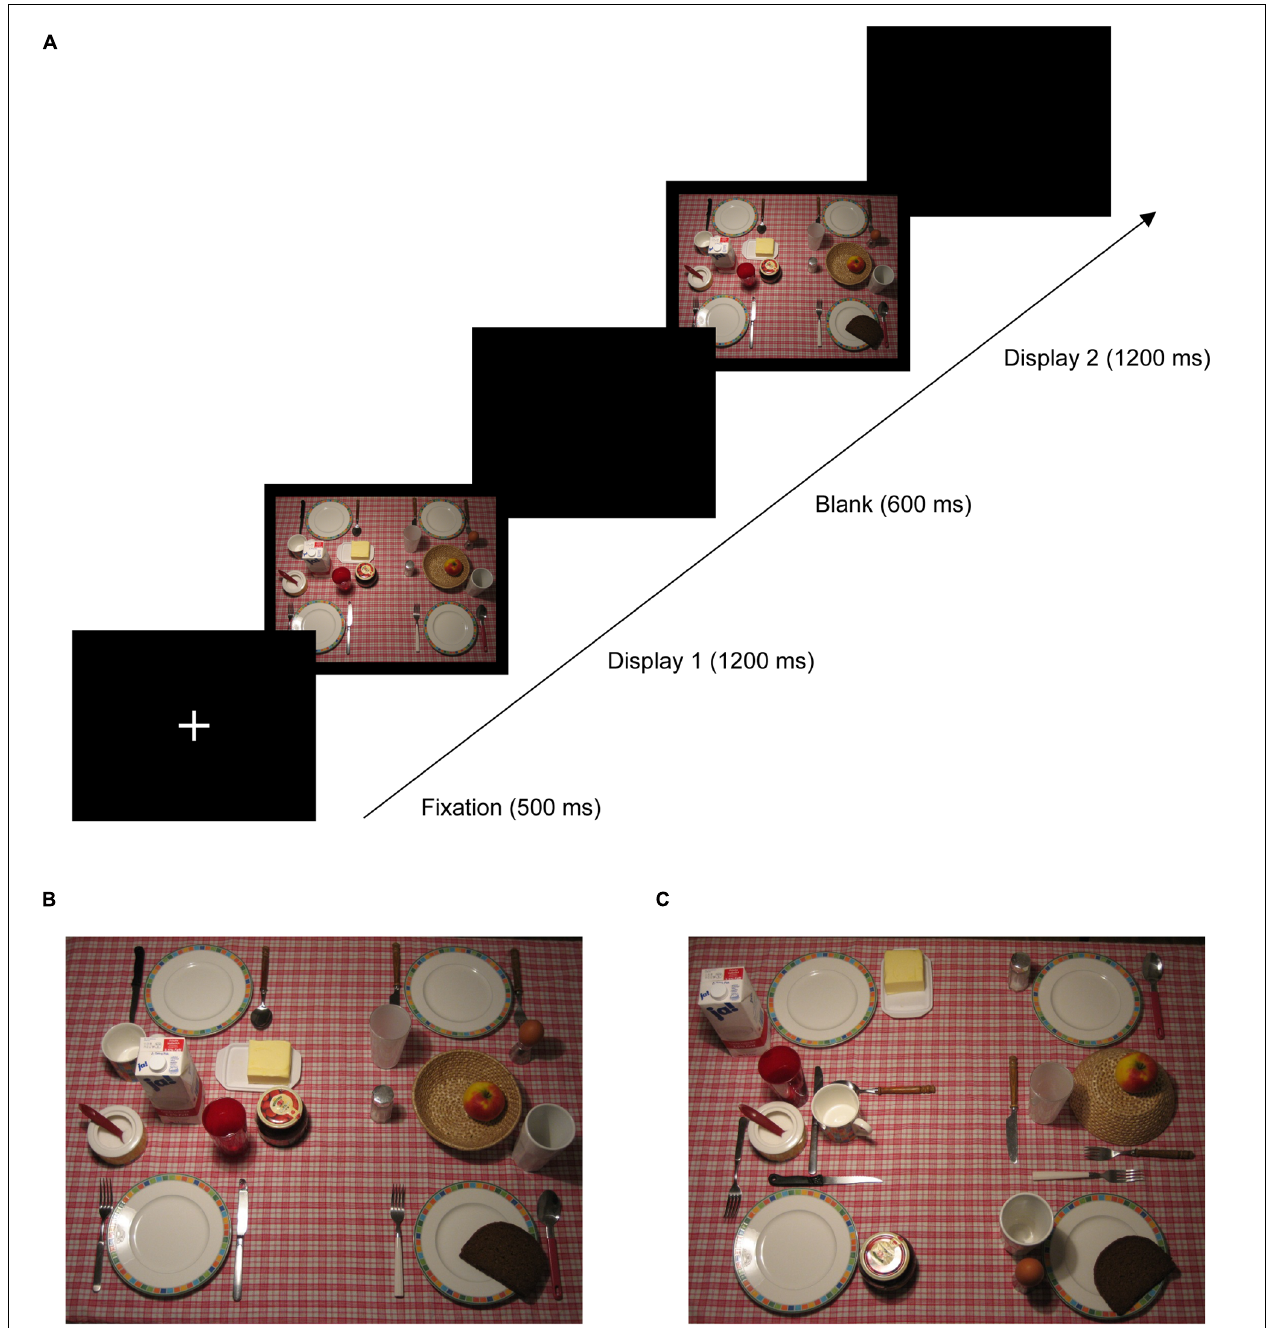
FIGURE 2 | (A) Schematic trial sequence in Experiment 1: each trial started with a fixation cross presented for 500 ms, followed by two search displays presented for 1200 ms each and separated by a blank display presented for